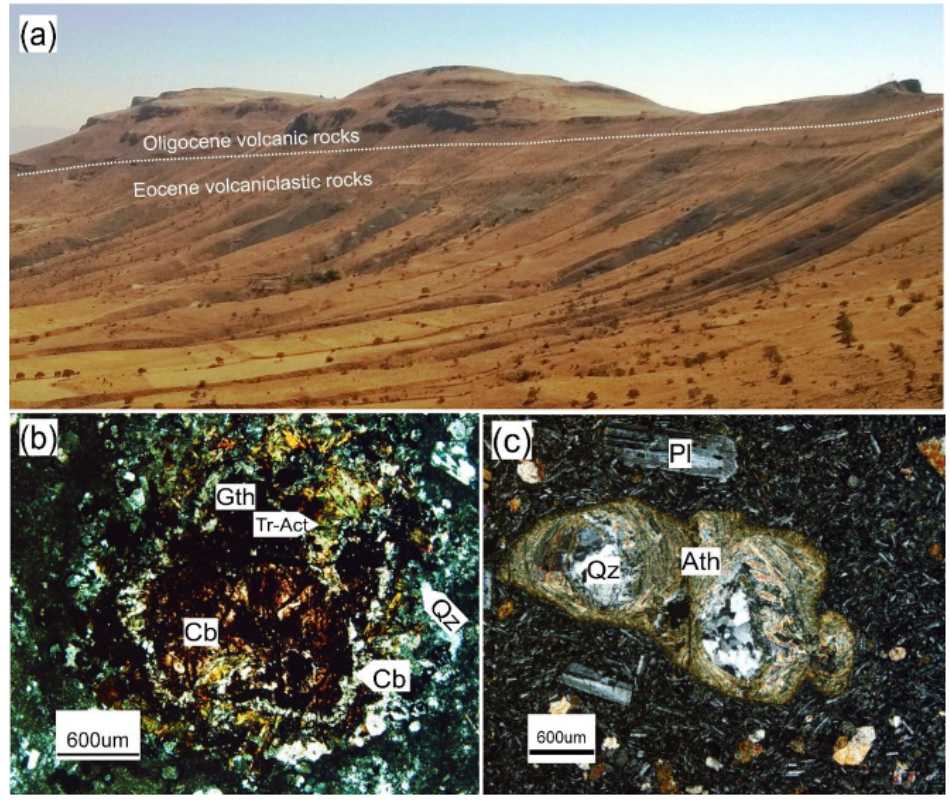
Figure 6. Field photograph and photomicrographs of Shah-Ali-Beiglou area: ( a ) The unconformable contact of Eocene volcaniclastic rocks and Oligocene lavas in south of the study area; ( b ) A xenolith in trachylatite rock that is altered to an assemblage of carbonate, quartz, tremolite-actinolite (Tr-Act), and goethite (Gth) minerals (crossed-polarized light); ( c ) The second phase of the alteration in a trachy-basalt rock in which the serpentine resulted from the olivine (in the first phase), is altered to anthophyllite (Ath) filled with quartz (Qz) (crossed-polarized